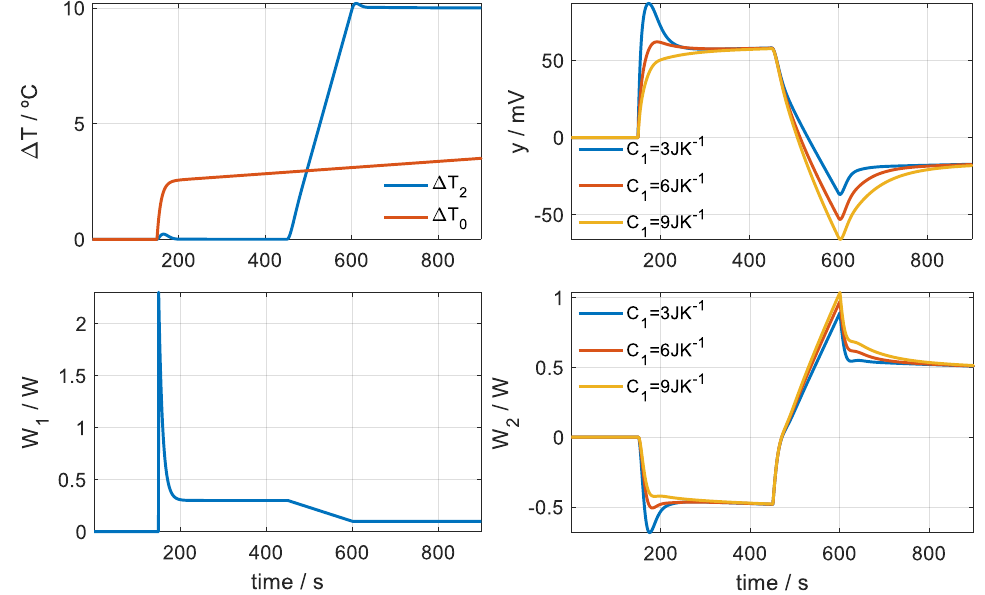
Figure 8. Simulation of a measurement on human skin for different heat capacities of the skin. Curve baselines have been corrected.